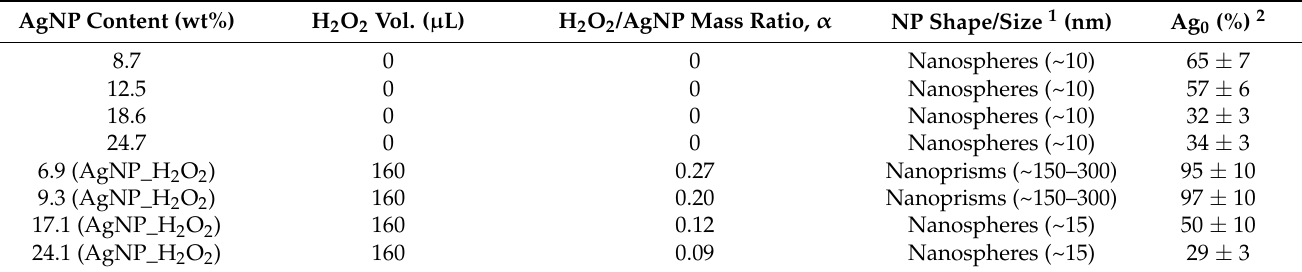
Figure 2. STEM images of CNC/AgNP hybrids at various α values. The scale bar is 500 nm. Table 2. Characteristics of hybrids with and without H 2 O 2 post-treatment.